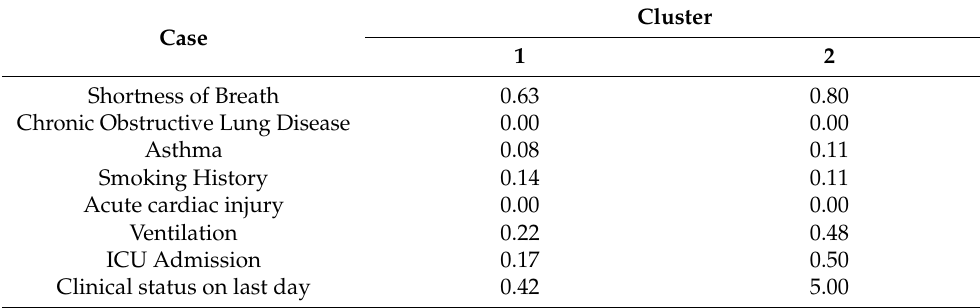
Table 7. Final cluster